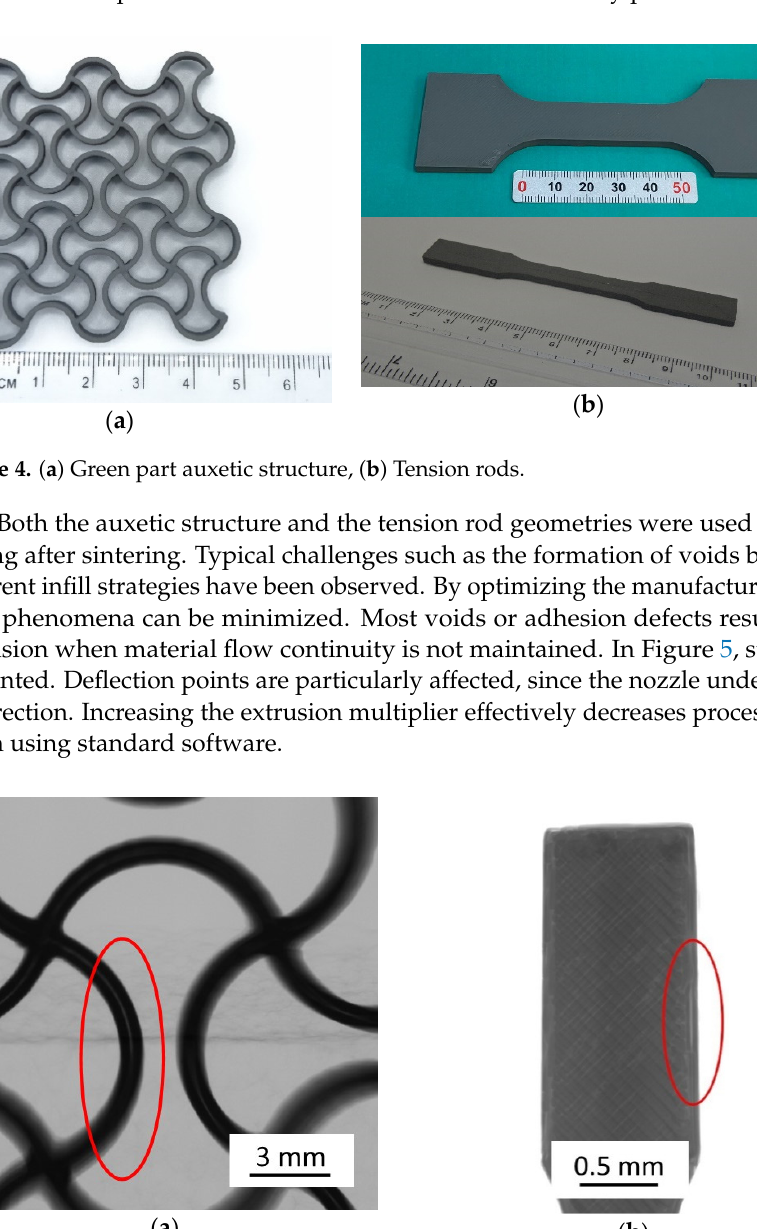
Figure 3. ( a ) Homogeneous feedstock granulated with a solid loading of 63 vol.%, ( b ) Continuous spooling of the 1.75 mm NiTi filament.